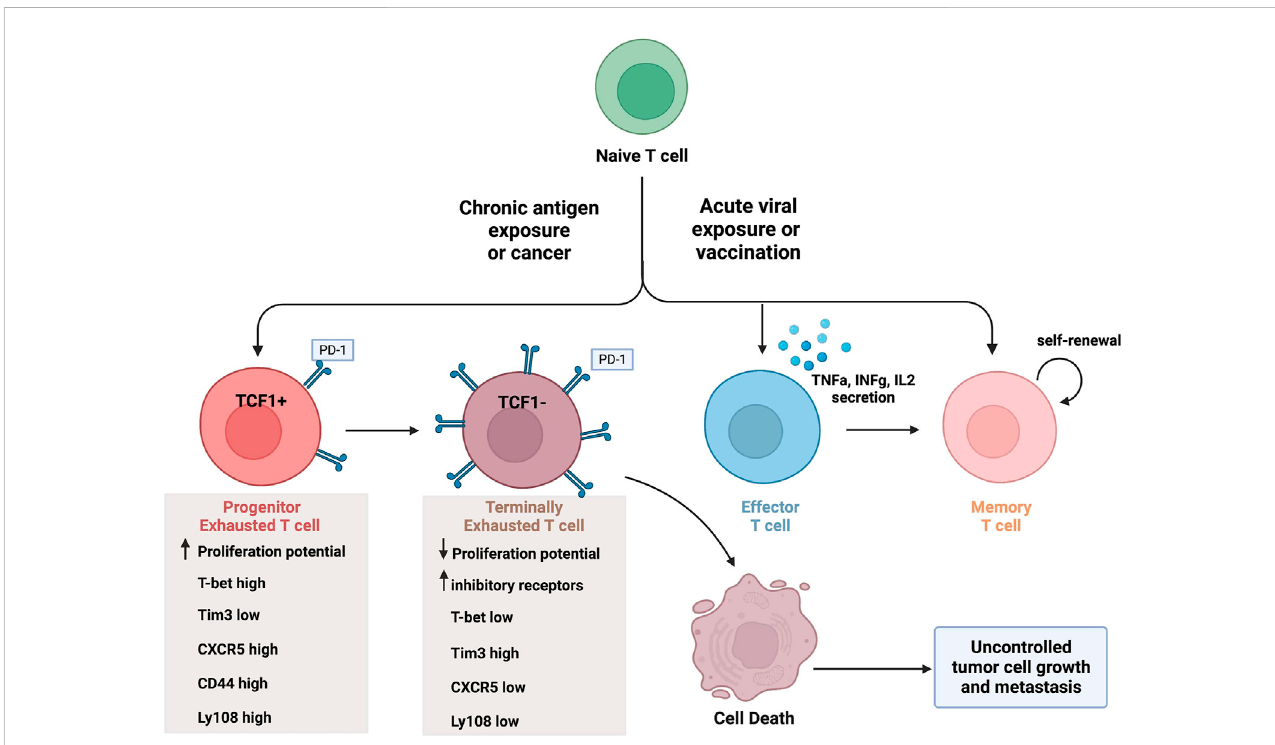
FIGURE 1 CD8 + T cell differentiation in the tumor microenvironment and during acute infection. Naïve T cells can differentiate into various CD8 + T cell subsets uponacuteantigenexposure,andthisvariesincomparisontochronicantigenexposure.Effector Tcellsarecapableofsecretingcytokinesandhavecytolytic activity. A portion of effector T cells can differentiate into memory T cells, capable of self-renewal, or undergo cell death. In contrast, exhausted T cell populations lack effector activity and undergo cell death. Progenitor T ex cells express TCF1 (as well as other markers) and have enhanced proliferation potential. Terminal T ex cells do not express TCF1 (and increased inhibitory receptor expression) and have reduced proliferation potential. Created with